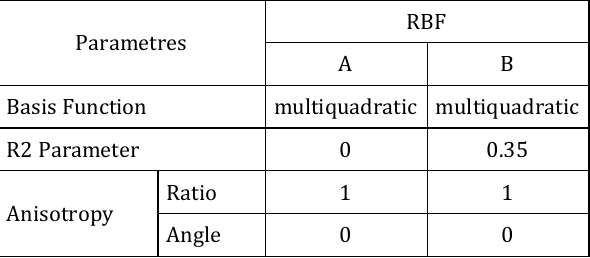
Table 3. Parameters used for the radial basis function (A – the heap surface, B – interior of the